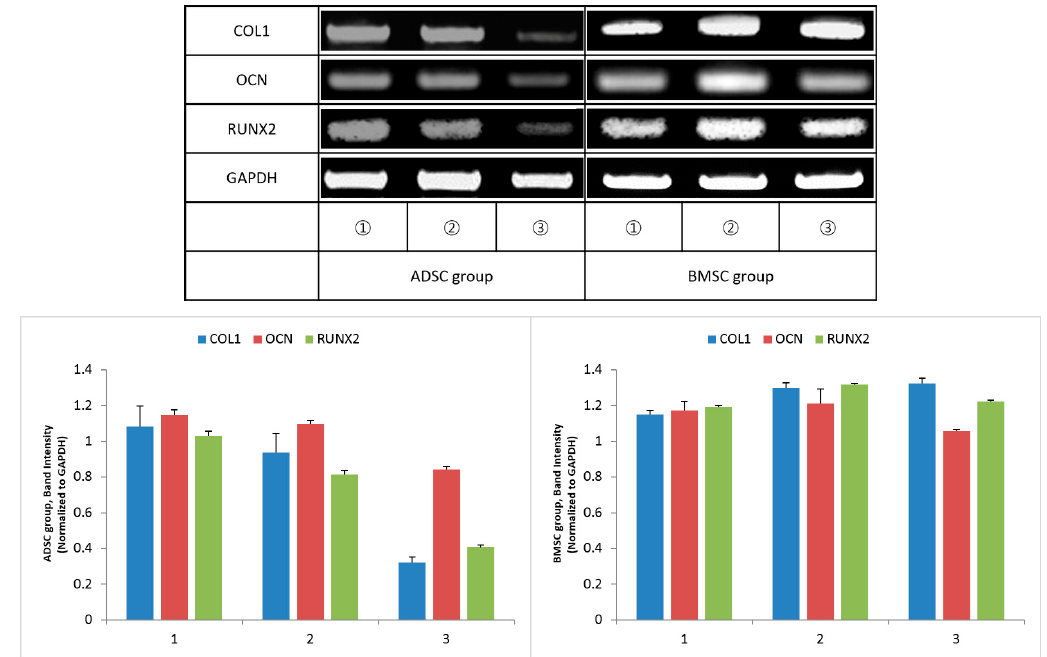
Figure 10. Expression of type 1 collagen (COL1), osteocalcin (OCN), runt-related transcription factor 2 (RUNX2) and glyceraldehyde-3-phosphate dehydrogenase (GAPDH) 12 weeks after surgery, measured by reverse transcription polymerase chain reaction (RT-PCR). ADSC, adipose-derived stem cell; BMSC, bone marrow stem cell.